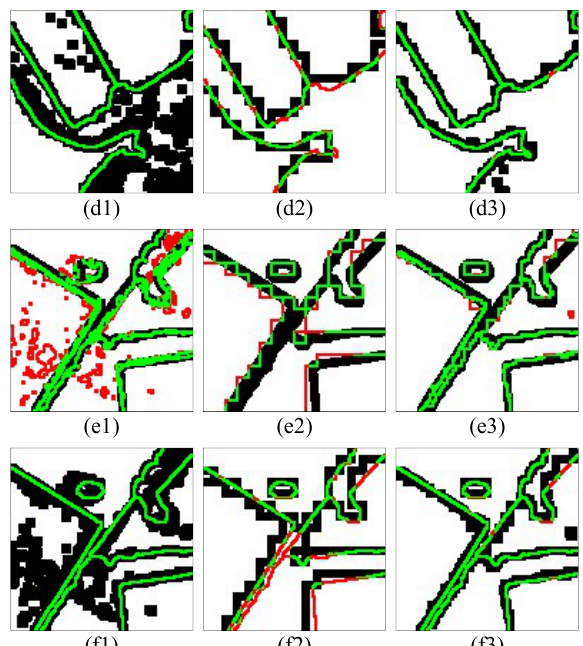
Figure 6. Buffer area analysis of segmentation boundaries. (a1)-(f1) HMRF-FCM, (a2)-(f2) RT-HMRF-FCM, (a3)-(f3) The proposed algorithm.